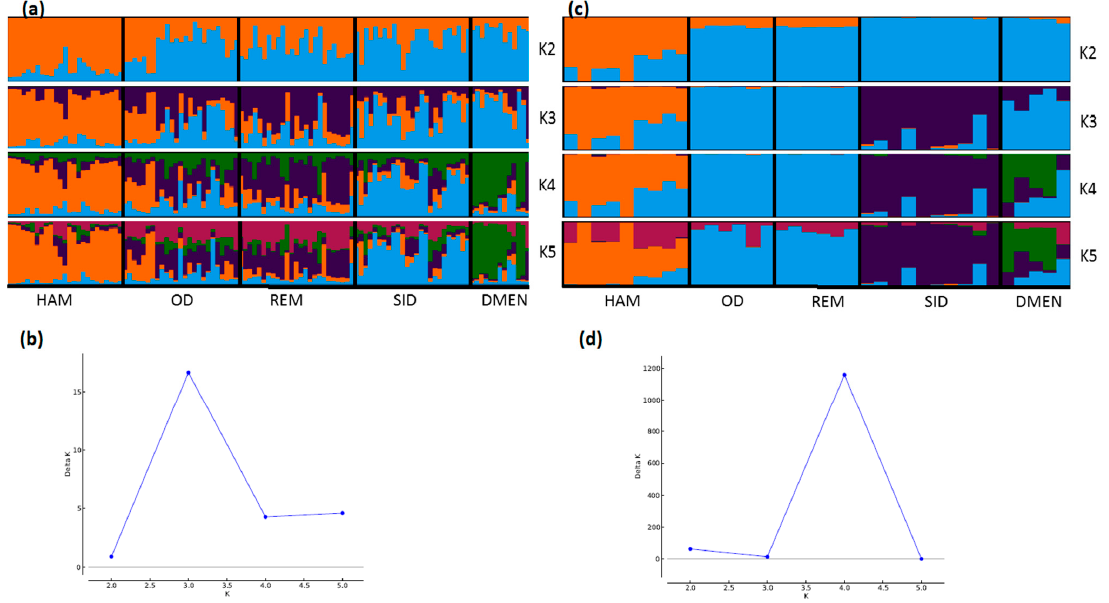
Figure 5. Genetic structure of Algerian sheep breeds by Bayesian analysis (K = number of clusters). ( a ) STRUCTURE plot obtained from the microsatellite dataset; ( b ) graph showing Δ K calculated according to [42] for the microsatellite dataset; ( c ) STRUCTURE plot obtained from the SNP dataset; ( d ) graph showing Δ K calculated according to [42] for the SNP dataset. For breed names see codes in